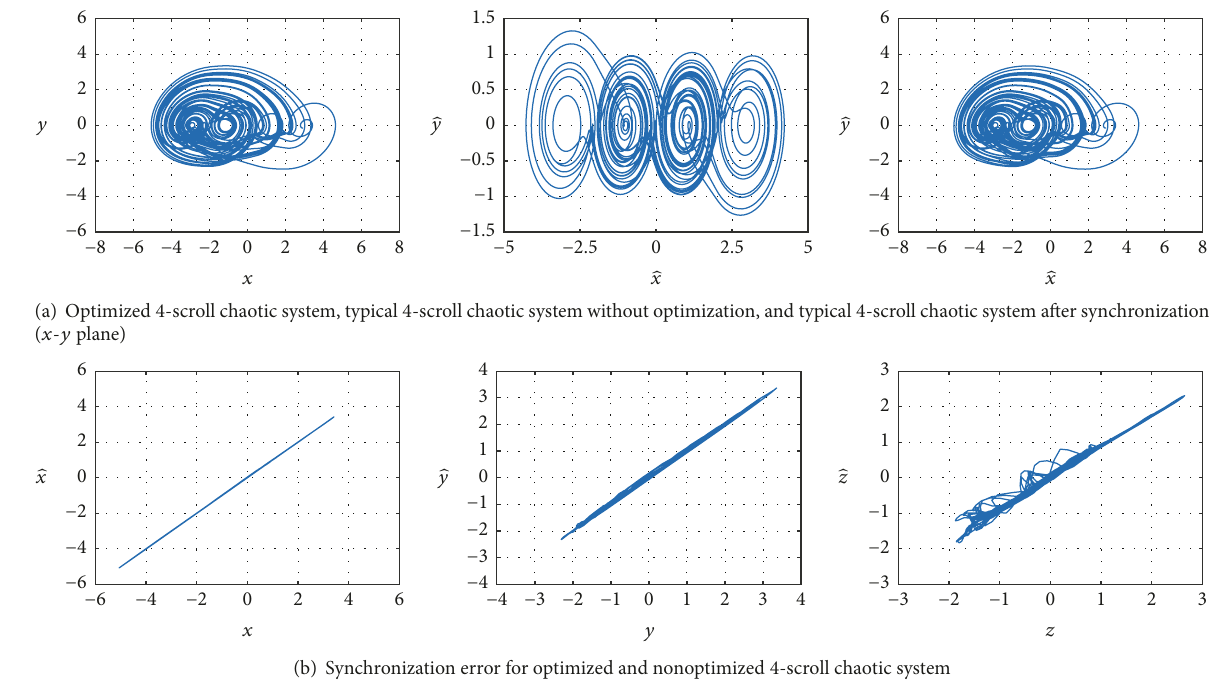
(b) Synchronization error for optimized and nonoptimized 4-scroll chaotic system Figure 14: Synchronization results between optimized and nonoptimized chaotic oscillators with different delays of the slopes.